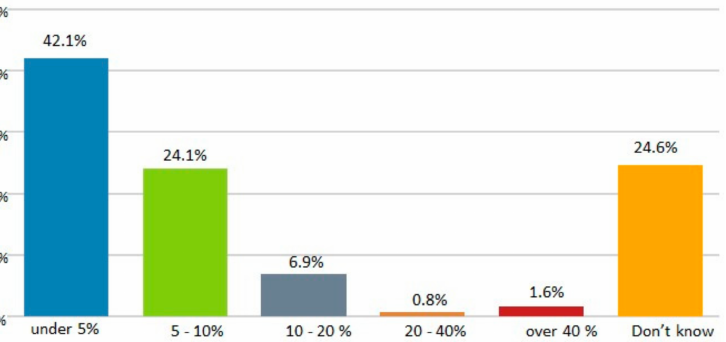
Figure A2. The percentage of energy bills (electricity and heating) of the total household disposable